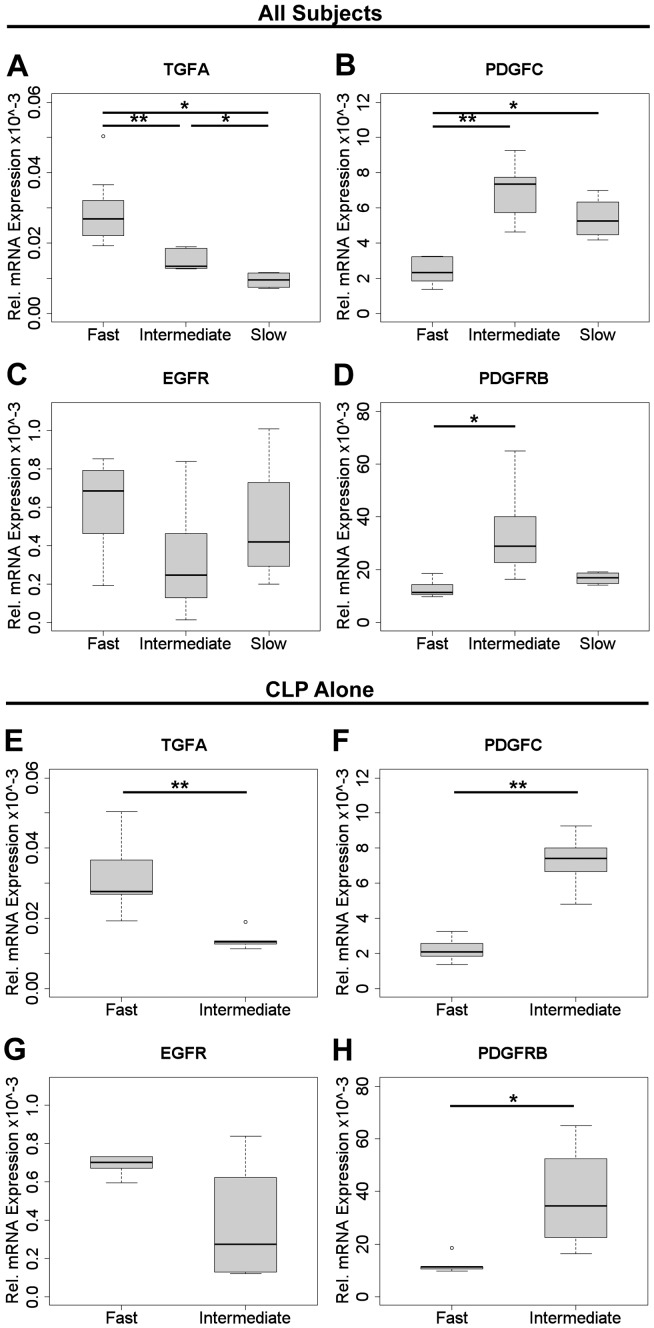
Different expression levels of TGFA, PDGFC, EGFR and PDGFRB in the three migratory groups.Expression levels were determined for the various mRNAs by qRT-PCR and normalized relative to GAPDH. Results are represented by boxplots; whiskers indicate the maximum and the minimum values in each group (*p<0.05; **p<0.01). (A) TGFA was significantly up-regulated in the “fast” migratory group. The difference between the “intermediate” and “slow” migratory groups was also significant. (B) PDGFC was down-regulated in the “fast” migratory group compared to “slow” and “intermediate” migratory groups. The difference between the “slow” and “intermediate” migratory group was not significant. Expressions levels of the respective receptors EGFR and PDGFRB: (C) The mRNA of EGFR showed roughly the same tendency, but was not significant. (D) PDGFRB was significantly down-regulated in “fast” migratory group compared to the “intermediate” migratory group. Differences in expression level of the same mRNAs were persistent when comparing the “fast” with the “intermediate” migratory group within the CLP cohort: (E) TGFA; (F) PDGFC; (G) EGFR, and (H) PDGFRB.